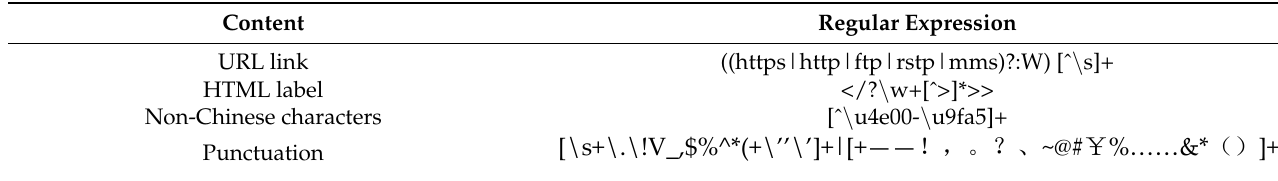
Table 4. Examples of stopping words.